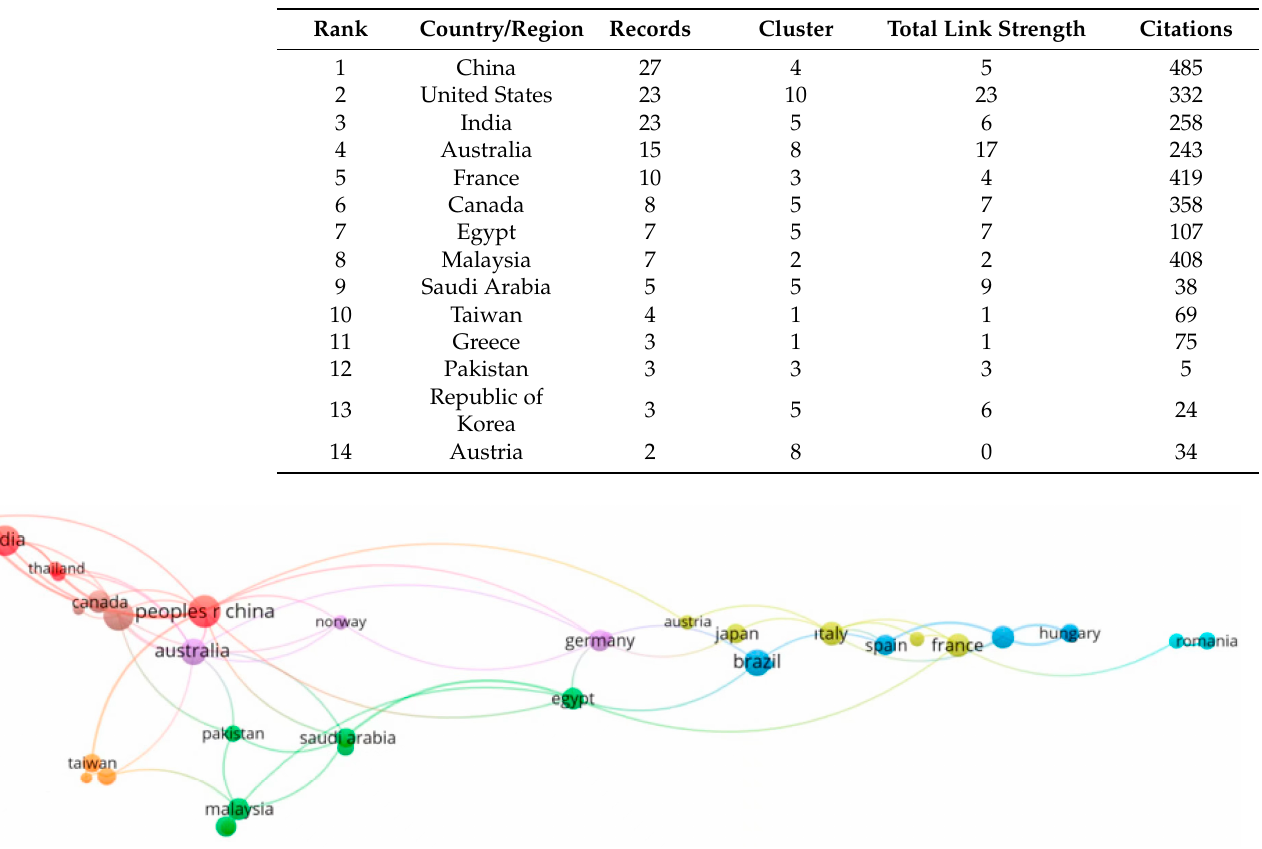
Figure 3. The country co-authorship network of research on biodiesel production from essential oil with 38 nodes and 8 clusters.